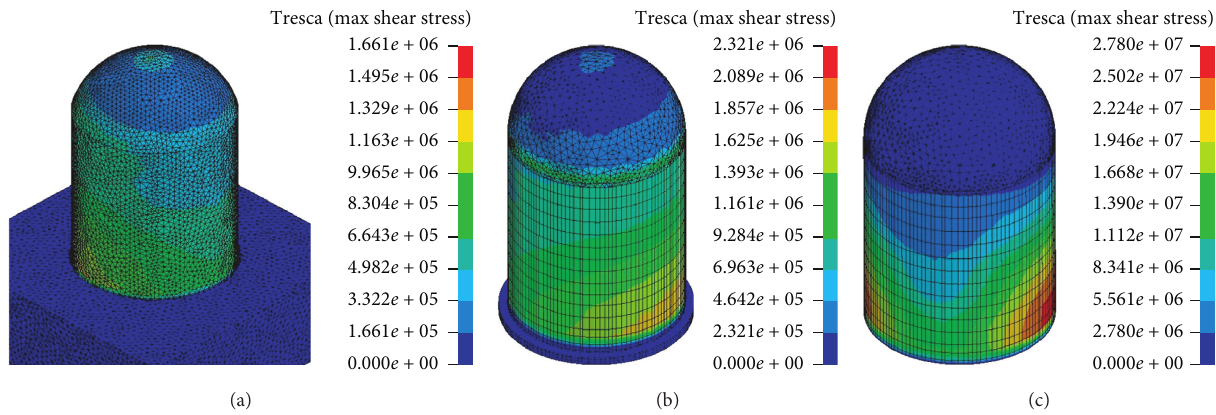
Figure 13: Comparison of critical shear stress (Tresca) response of SSIS-NC (a), CAMSBID-NC (b), and FB-NC (c) models under the effect of the 2011 Tohoku earthquake.